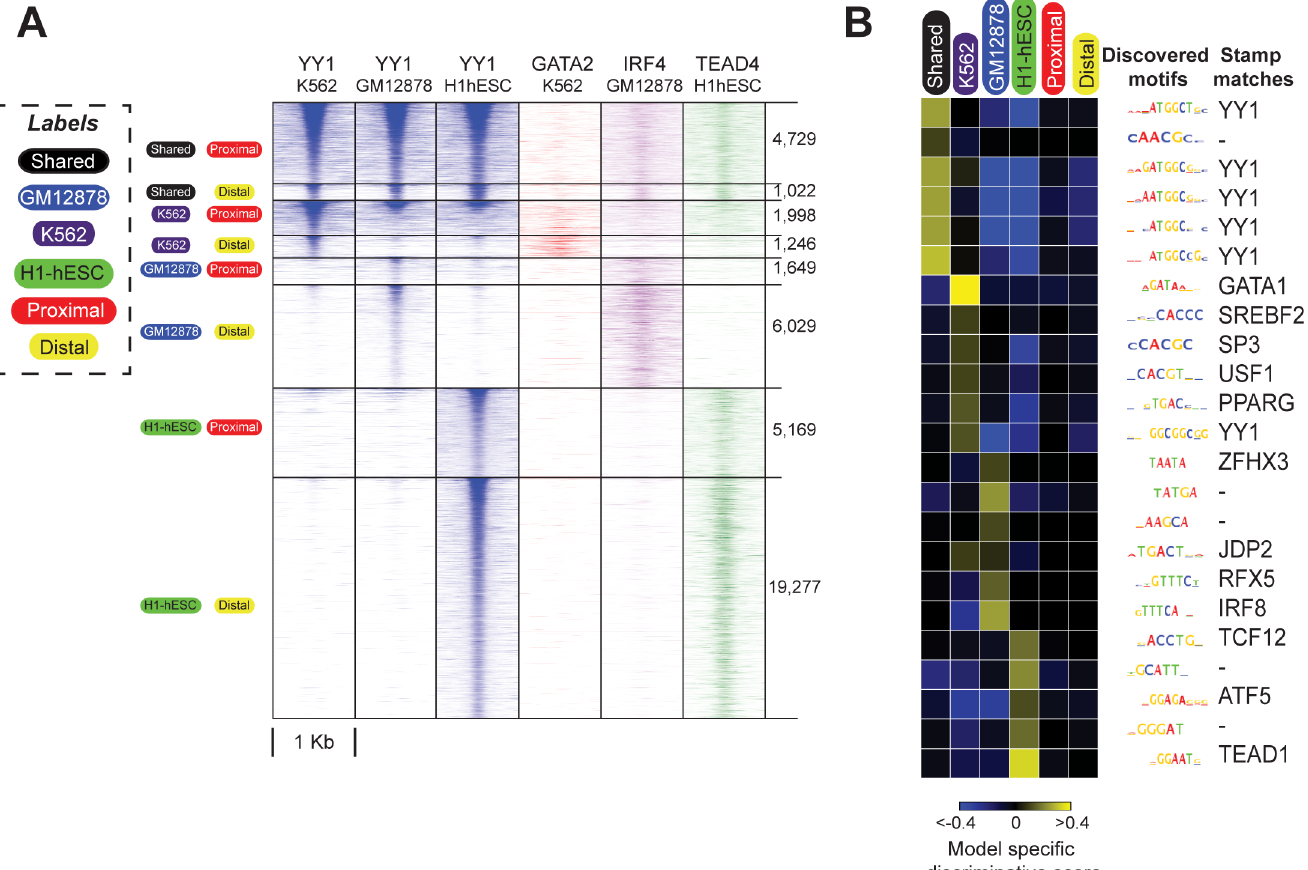
PLOS Computational Biology | https://doi.org/10.1371/journal.pcbi.1005795 October 19,